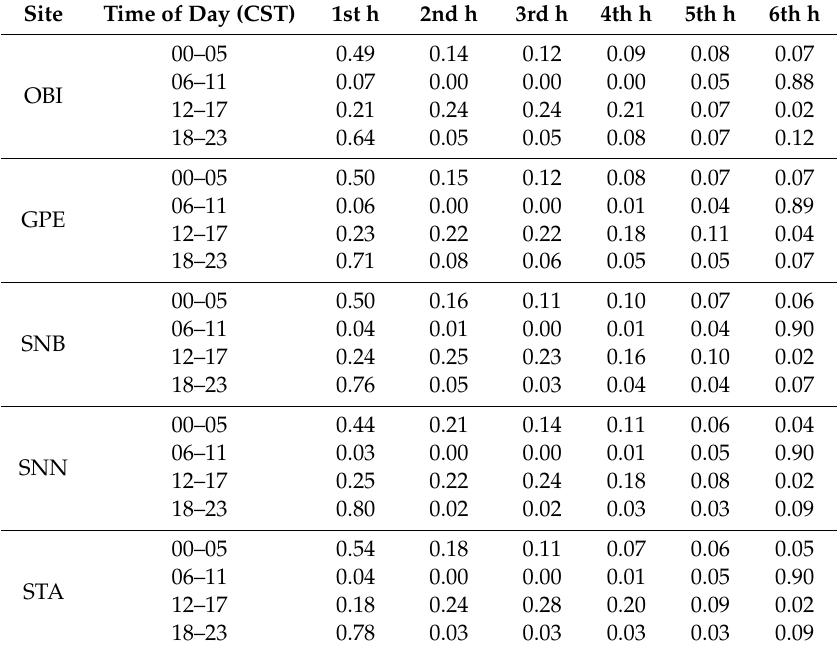
Table 3. Hourly weights per time of day used to calculate weighted averages of meteorological variables at each site; hourly periods are shown in